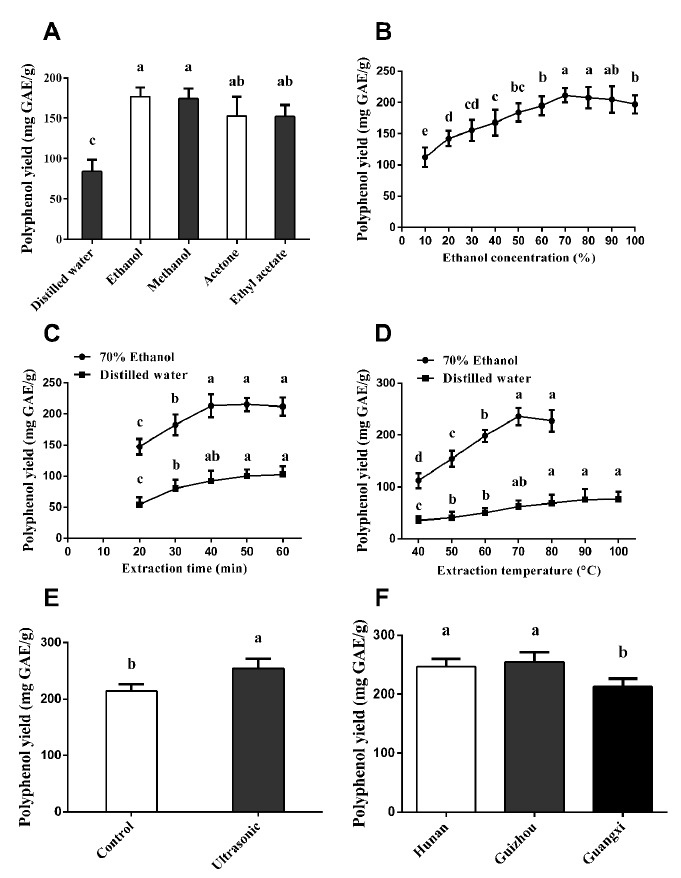
Figure 2. Conditions for extracting the vine tea polyphenols. ( A ) Polyphenol yield extracted by different solvents. ( B ) Polyphenol yield extracted by different concentrations of ethanol. ( C ) Polyphenol yield extracted by 70% ethanol with different times. ( D ) Polyphenol yield extracted by 70% ethanol at different temperatures. ( E ) Polyphenol yield extracted by 70% ethanol alone (control) and 70% ethanol plus ultrasonic treatment (ultrasonic). ( F ) Polyphenol yield of vine tea from different locations. The data represent mean ± SD with three repeats, and different letters in the same column indicate significant differences ( p < 0.05).